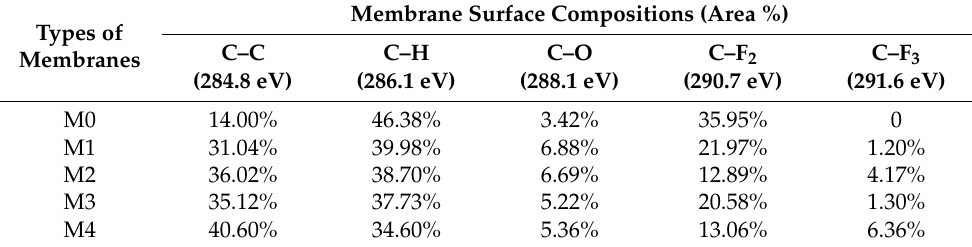
Table 2. XPS analysis results on C1s core-level spectrum of each membrane resolved into different binding